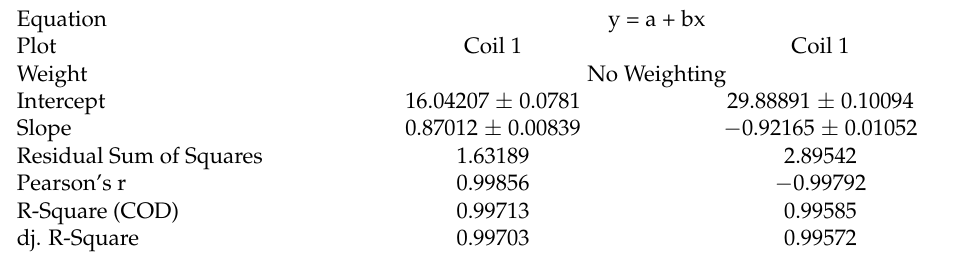
Table 1. The linear fit results of the coil